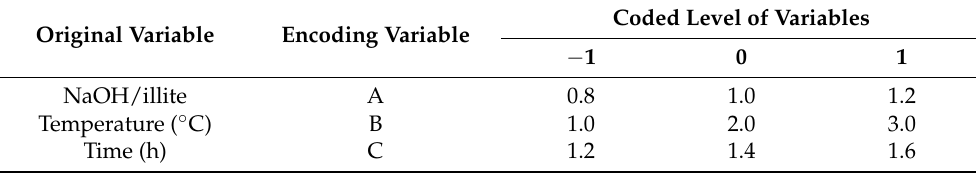
Table 1. Coded levels of input variables.